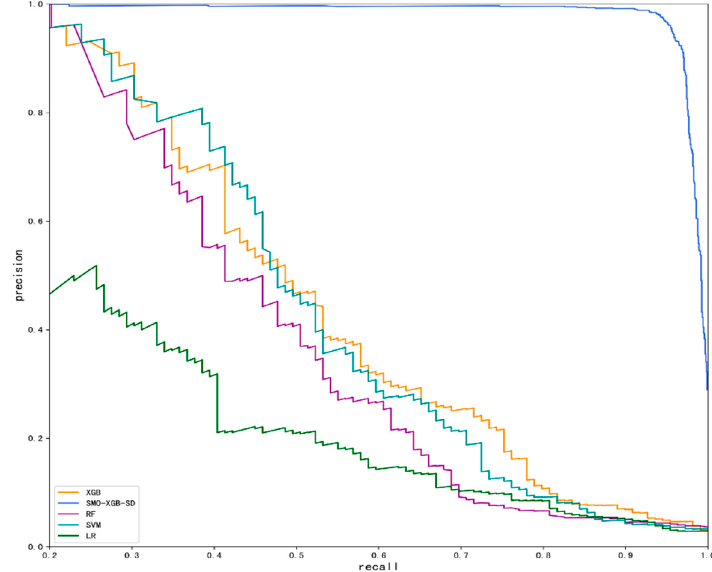
Figure 9. Precision recall (PR) curves of the five classification models.